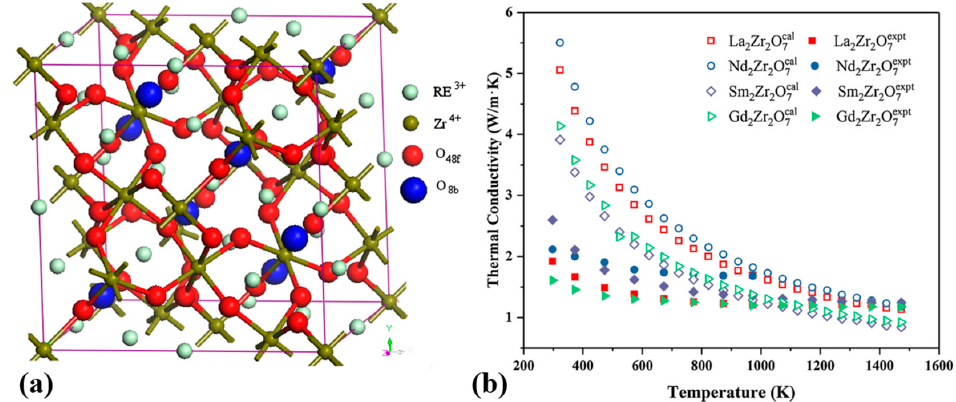
Figure 35. ( a ) Crystal structure ( b ) calculated and experimental temperature-dependent thermal conductivities of the rare-earth zirconate [189,205,206] .